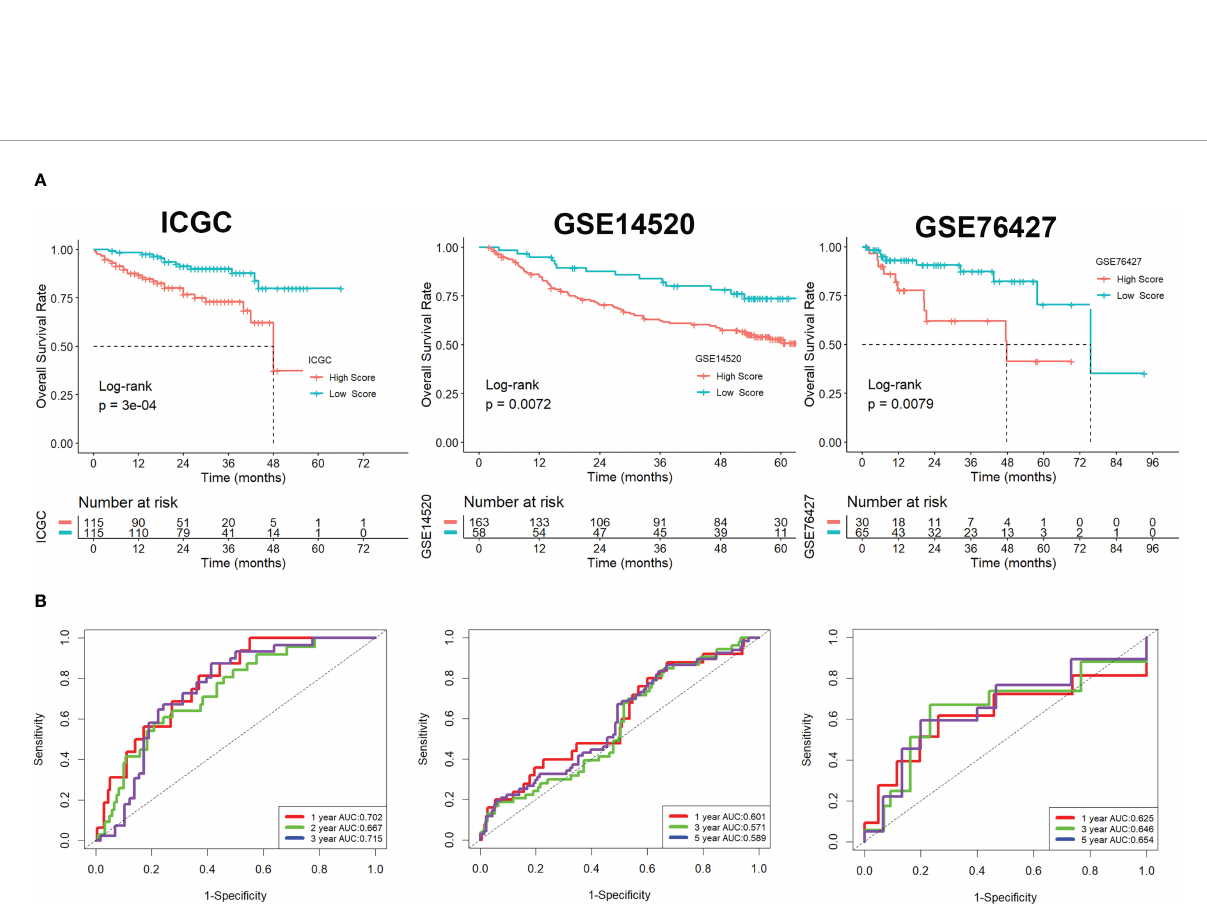
FIGURE 4 Validation of the signature in the ICGC and GEO cohorts. (A) Kaplan-Meier survival analysis. (B) ROC